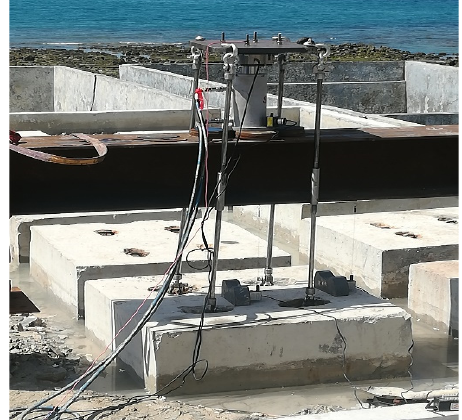
Figure 14. Vertical jack loading of Hc specimen.